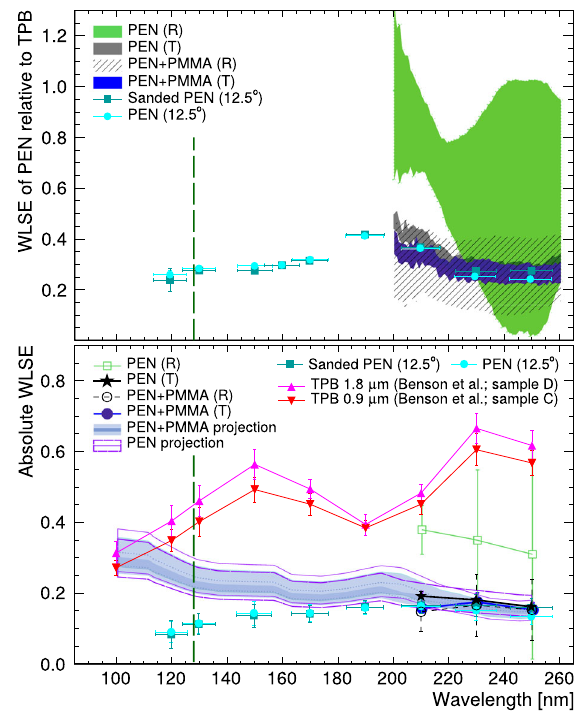
Fig. 3 Top: WLSE of standalone PEN and PEN on a substrate, relative to TPB on a substrate, measured in T- and R-mode IS configurations and with the VUV monochromator at 12.5 ◦ incidence (see legend). Data were taken at RT. Bottom: comparison of measured and inferred absolute WLSE of PEN. Also shown are TPB data points used for the absolute calibration [10] (lines drawn to guide the eye). The vertical dashed line marks the 128 nm LAr scintillation wavelength. See text and legend for more